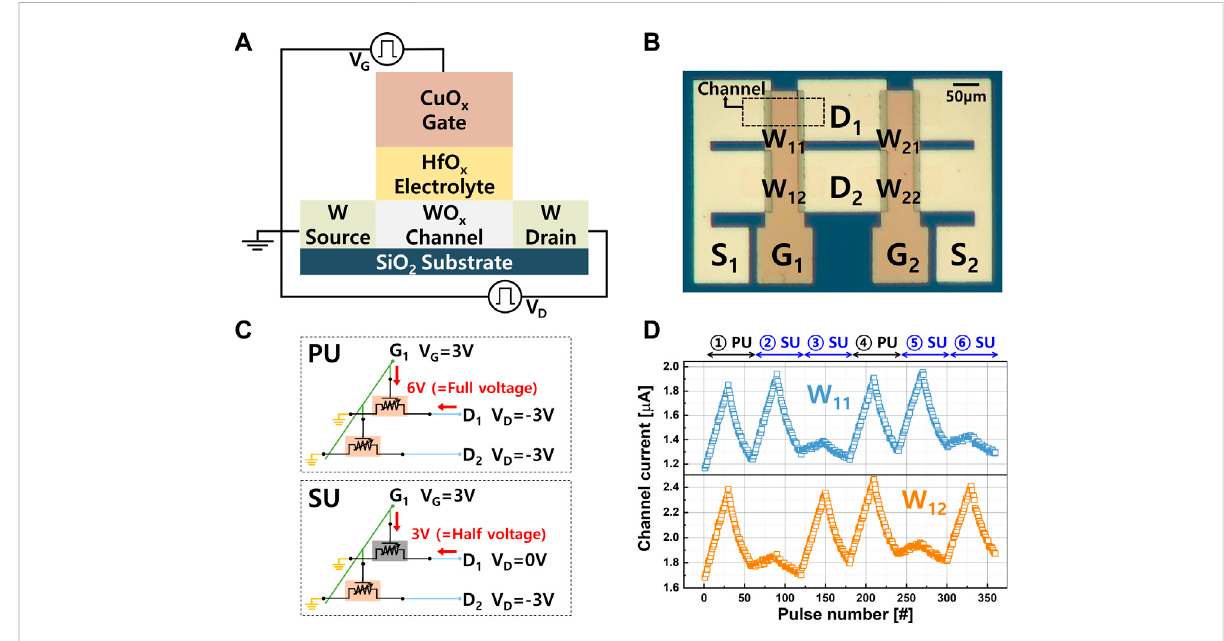
FIGURE 1 (A) Schematic diagram of unit ECRAM device and (B) optical microscopic image of the fabricated 2 × 2 ECRAM array. (C) Half-bias pulse conditions for PU and SU. (D) w 11 and w 12 can be simultaneously updated in parallel or sequential fashion.